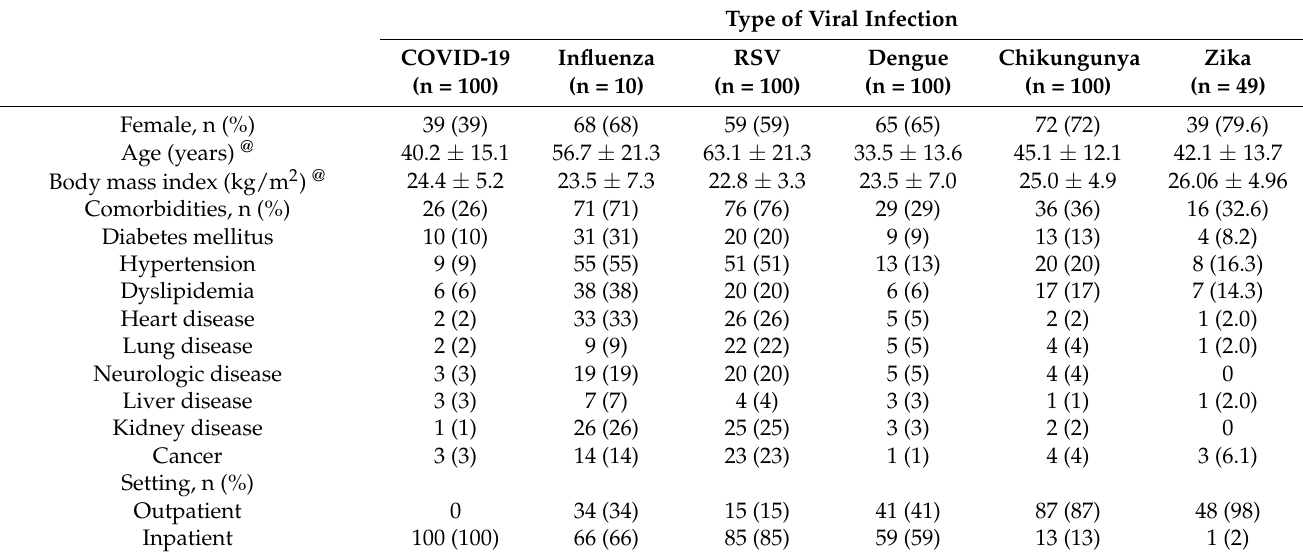
Table 1. Characteristics and baseline data of 549 patients with a confirmed diagnosis of COVID-19, influenza, RSV, dengue, chikungunya, or zika virus infection.